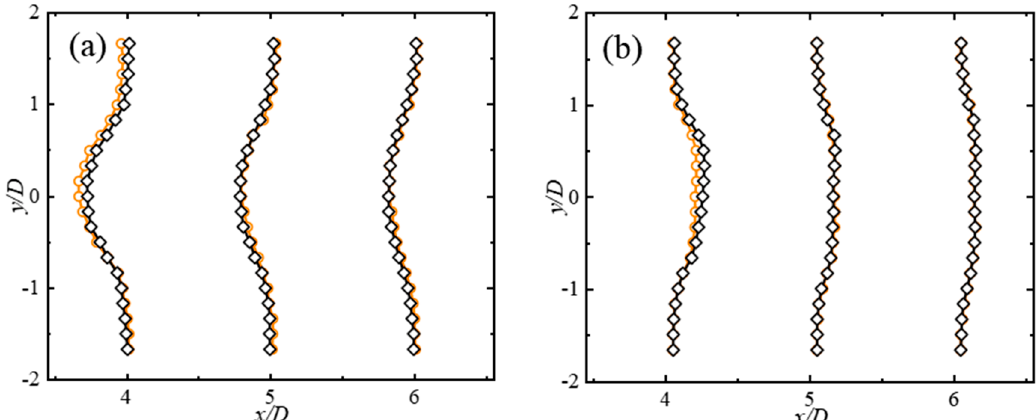
Figure 10. Comparison of the wake characteristics with different inflow velocities for U 06- Iu 06- γ 00 and U 09- Iu 06- γ 00 ( U 06- Iu 06- γ 00-Opt—orange dotted lines; U 09- Iu 06- γ 00-Opt—black rhomb lines). ( a ) Normalized mean velocity profile; ( b ) turbulence intensity profile.